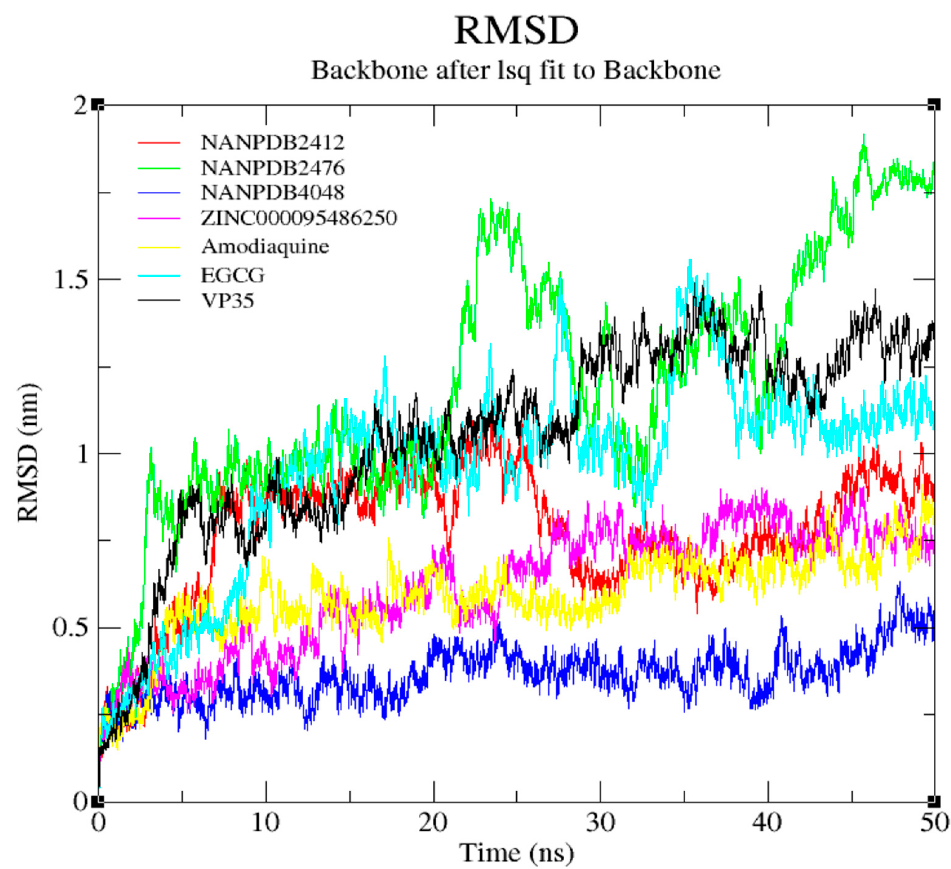
Figure 5. The time evolution of radius of gyration (Rg) for the EBOV VP35-complexes: Amodiaquine, EGCG, NANPDB4048, NANPDB2412, NANPDB2476, ZINC000095486250 and VP35 are indicated in yellow, cyan, blue, red, green, magenta and black, accordingly.